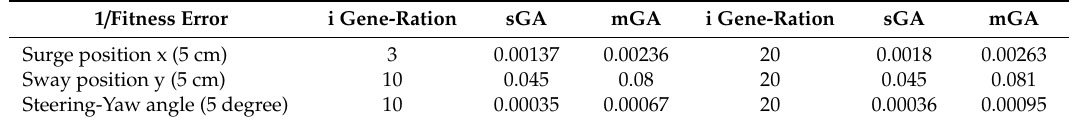
Table 3. The error fitness function by